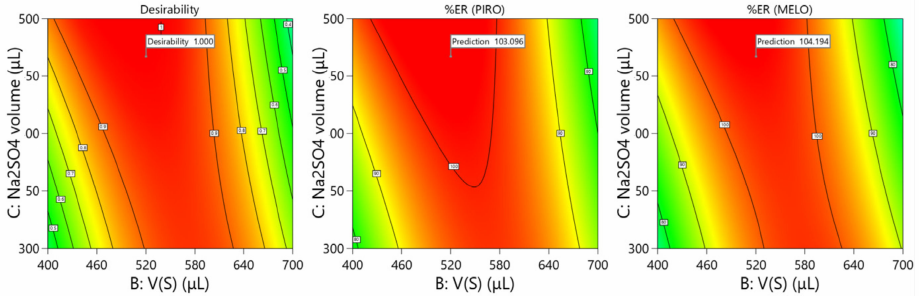
Figure 3. Contour desirability plots for PIR and MEL determination using